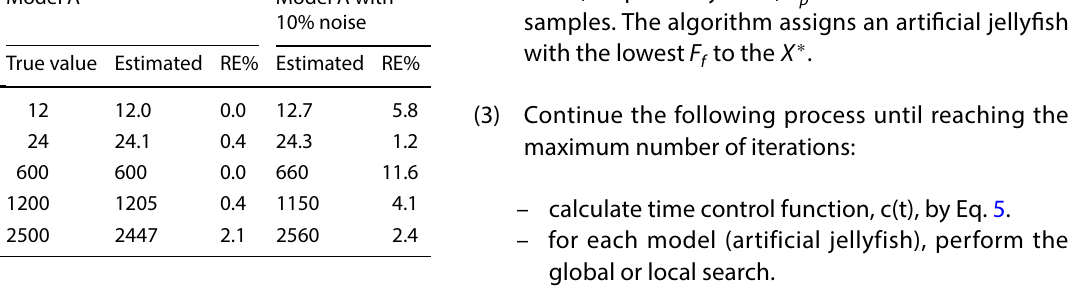
Fig. 2 the inversion of a three-layer model, model A, by the JS algo- rithm, a arrived times corresponding to model A (the black curve) and the estimated values (the red points), b arrived times corre- sponding to model A in the presence of 10% noise (the red points) and the estimated values (the black curve), c , d ) the RMSE over the